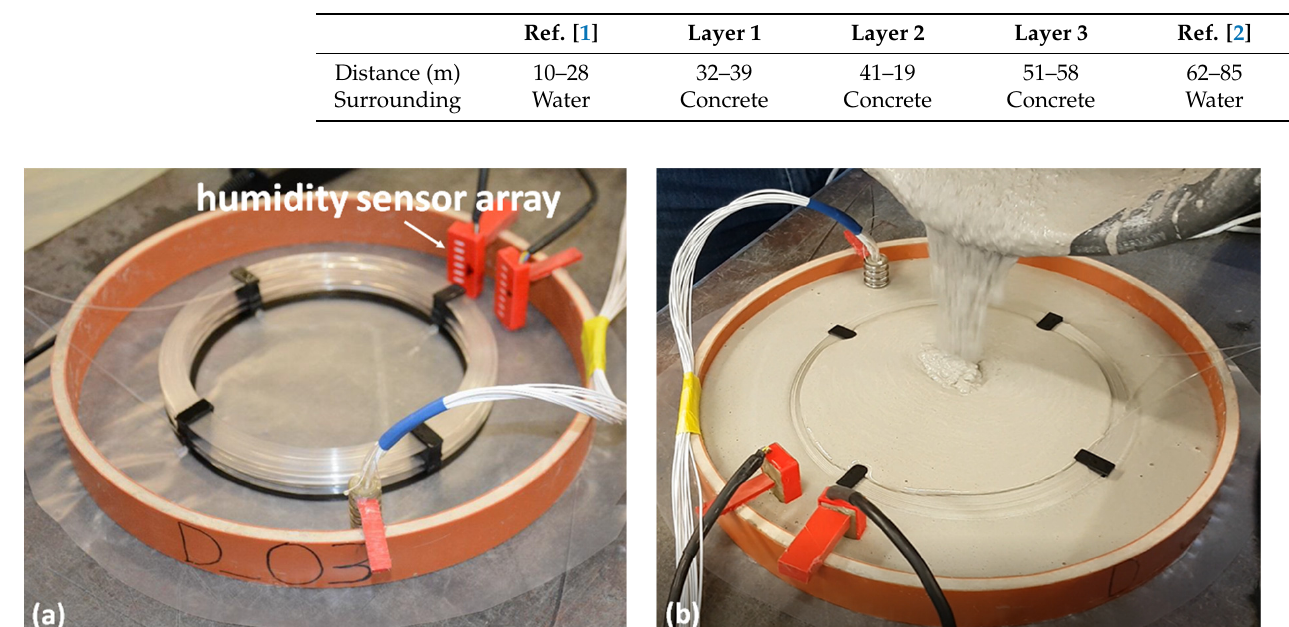
Figure 1. Humidity sensor arrays and the sensing fiber ( a ) before and ( b ) during concrete filling. Table 1. Information about different fiber sections.